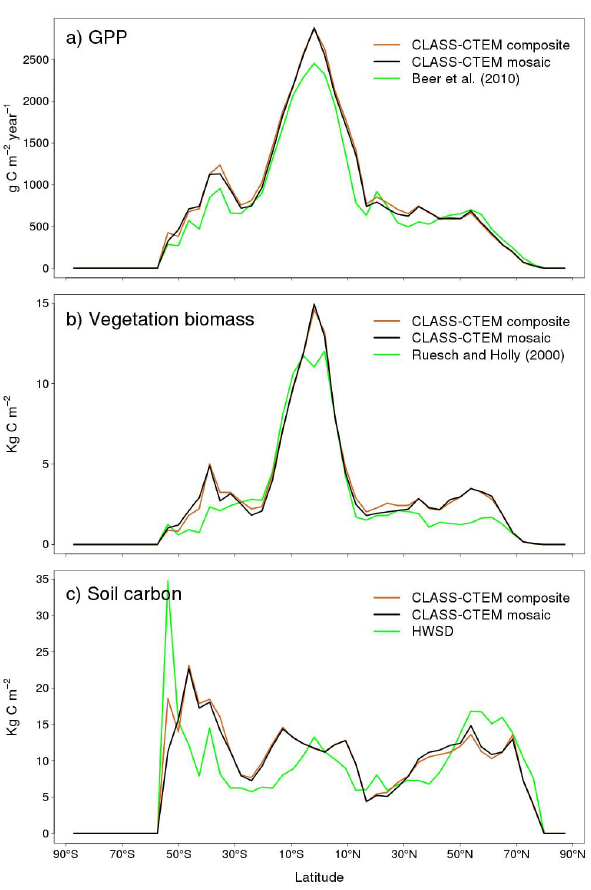
Fig. 2. Comparison of simulated zonally averaged (a) GPP, (b) veg- etation biomass, and (c) soil carbon with observation-based esti- mates. The CLASS-CTEM results from the simulations using com- posite and mosaic configurations are averaged over the 1996–2005 period and are from the Climate + CO 2 + LUC